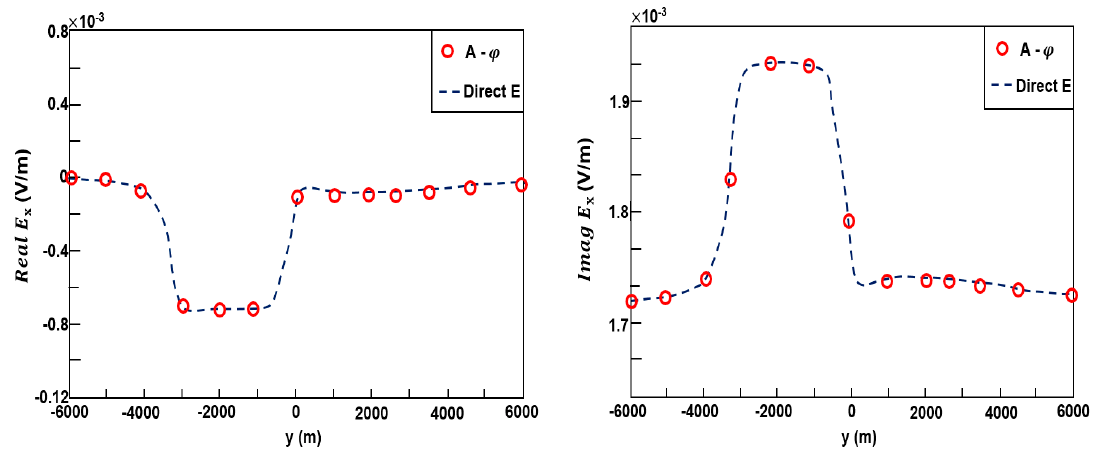
Figure 5. The plot of the E x polarization (real and imaginary) calculated using the Potential E and Direct E formulation.